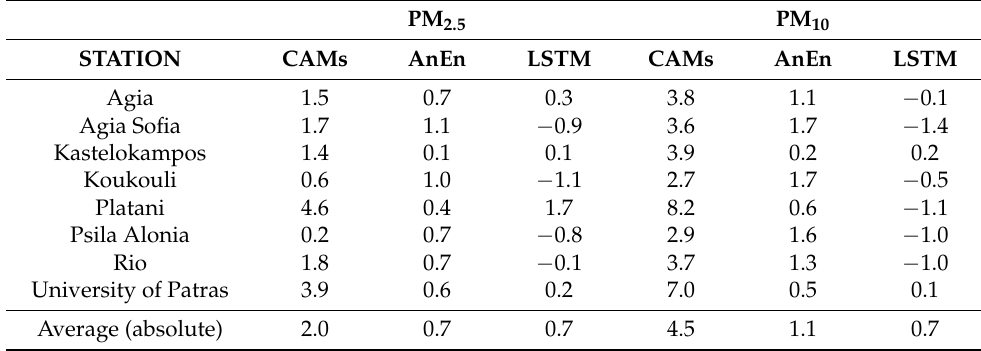
Table 3. MBE of PM 2.5 and PM 10 for forecasts of CAMS, AnEn and LSTM at each station.